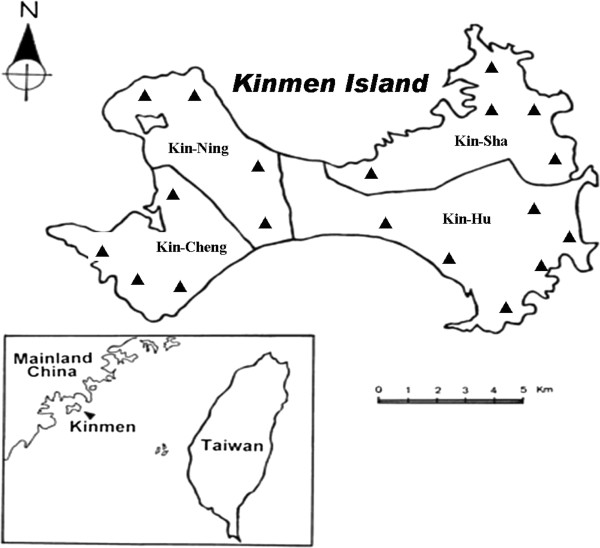
 Map of Taiwan and Kinmen Island, showing the geographic location of Kinmen Island and the collection sites (▴) forI. granulatusticks removed from captured rodents.